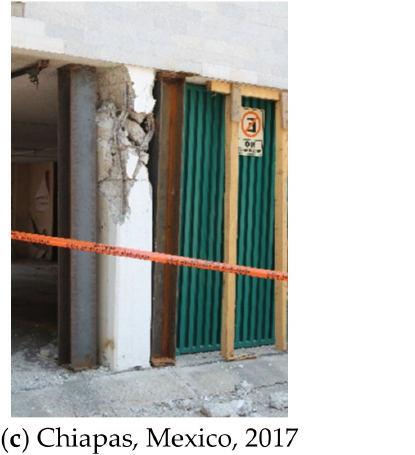
Figure 6. Damage Type 3—Example of post-earthquake damage in RC columns: ( a ) insufficient transverse reinforcement and longitudinal reinforcement in two faces only; ( b ) shear failure due to inadequate transverse reinforcement; ( c ) poor detailing and transverse reinforcement; and ( d ) inadequate stirrups